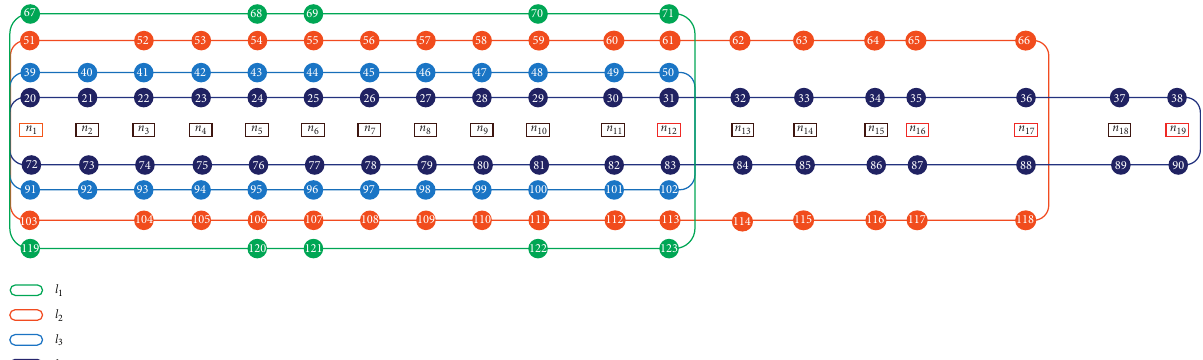
Figure 8: Optimized operation scheme for an urban rail transit